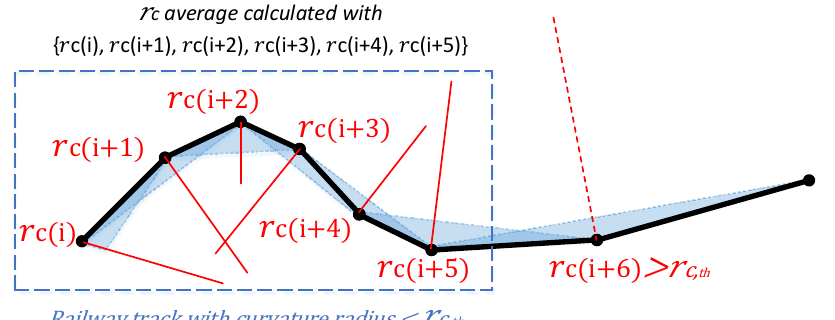
Figure 4. Concept illustration of the calculation of r C , av and its assignment to a point of a group of consecutive points with r C < r C , th